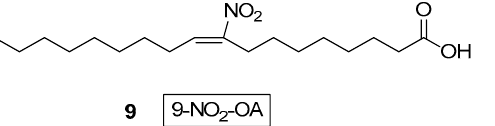
Figure 5. 9-NO 2 -OA as a cytotoxic agent against colorectal cancer cell lines.